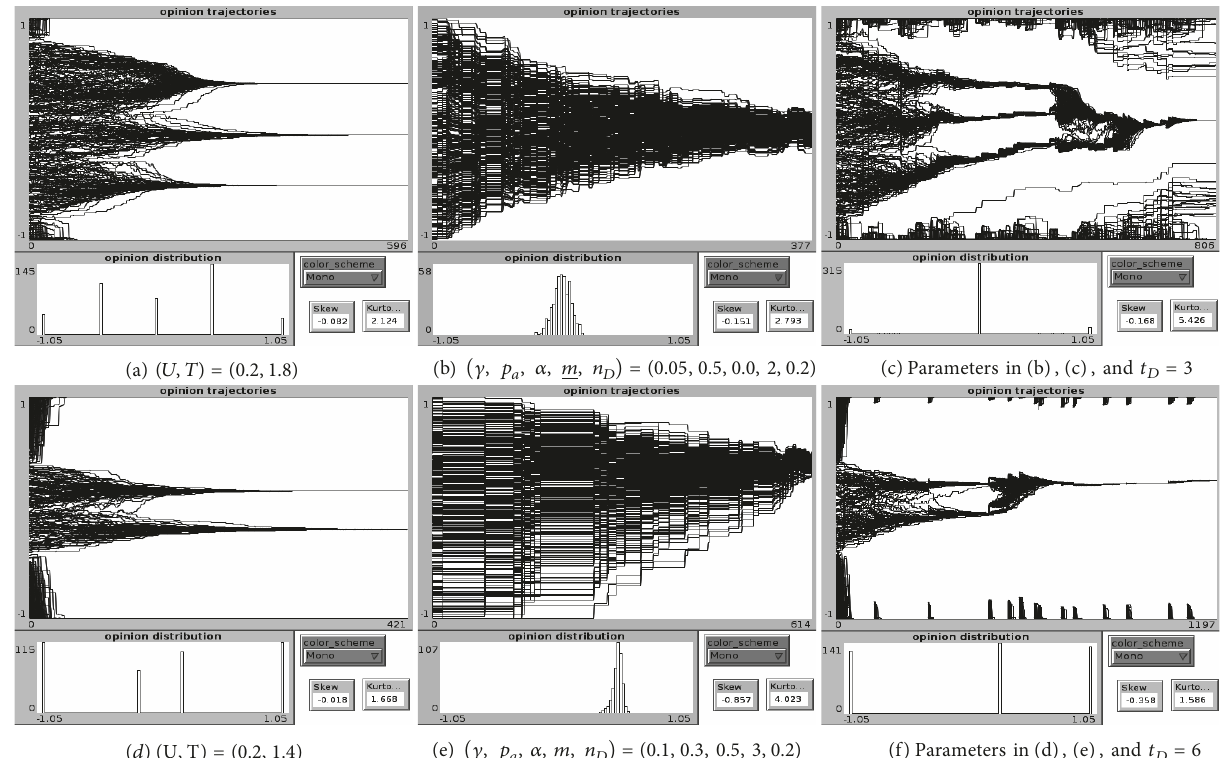
Figure 7: From left to right, common opinion trajectories and distributions for dyadic, deliberative, and mixed opinion dynamics within the structure of different decision-making